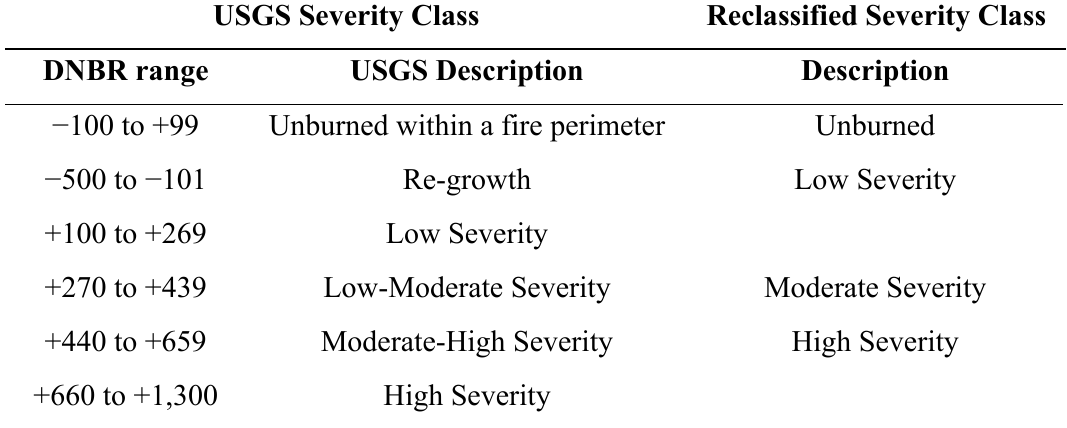
Table 1. Description of burn severity thresholds used to define severity classes (unburned, low, moderate, and